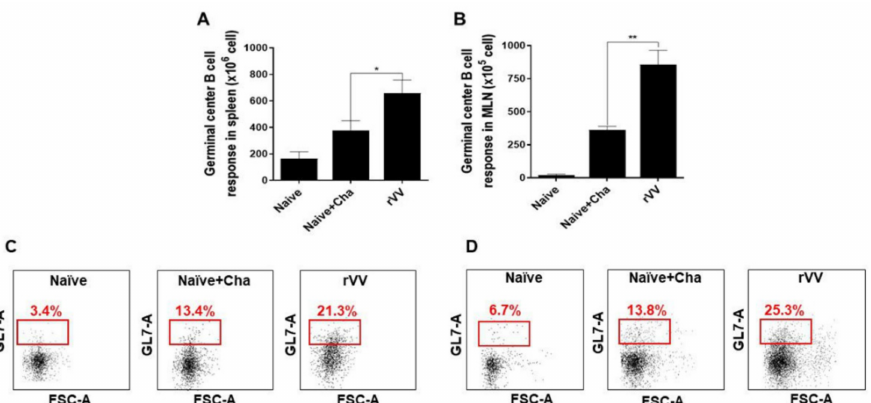
Figure 4. ROP4-rVV immunization induces potent GC B cell responses. Spleens and MLNs were har- vested from mice ( n = 6 per group) at 16 dpi and GC B cell proliferation was assessed by flow cytometry. GC B cell populations from antigen-stimulated spleen ( A ) and MLN ( B ) were evaluated. Representative scatterplots for both spleen ( C ) and MLN ( D ) were provided, with boxes indicating the gated GC B cell population. Data are presented as mean ± SD from 3 independent experiments performed in triplicates and asterisks denote statistical differences between groups (* p < 0.05, ** p <